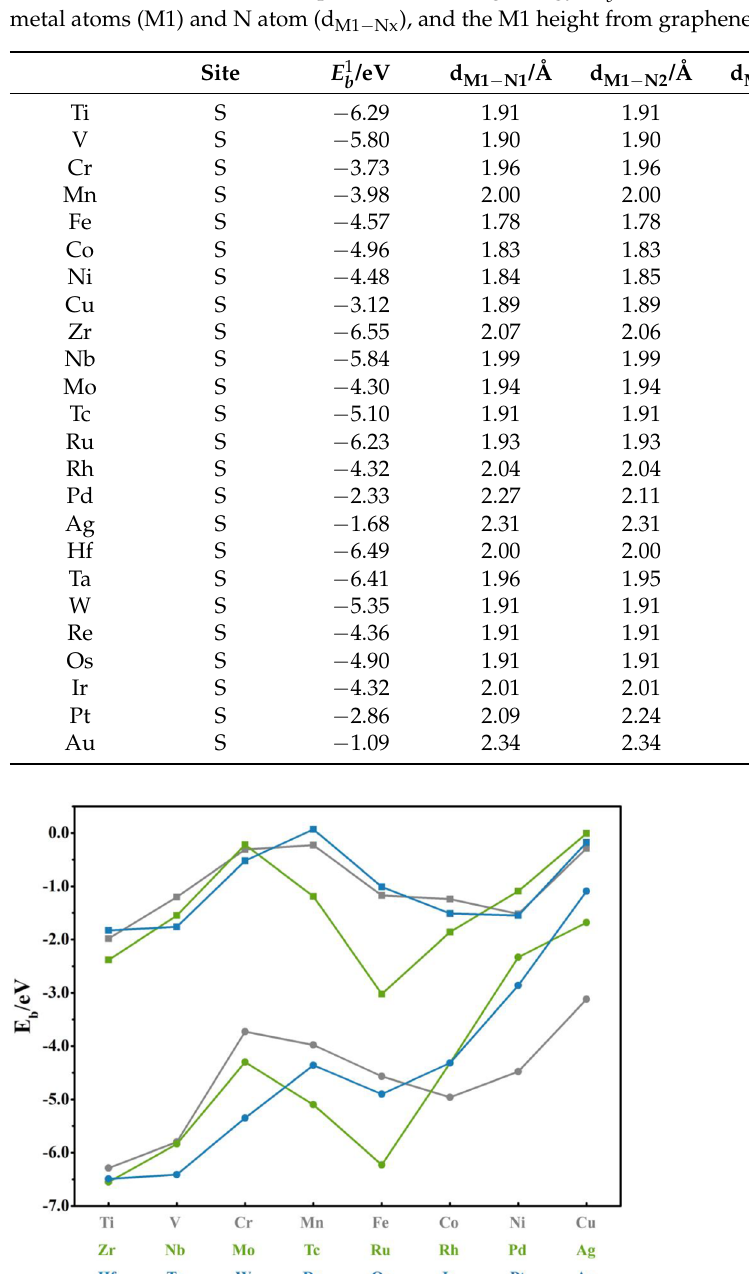
Table 2. The most stable adsorption site, binding energy ( E 1